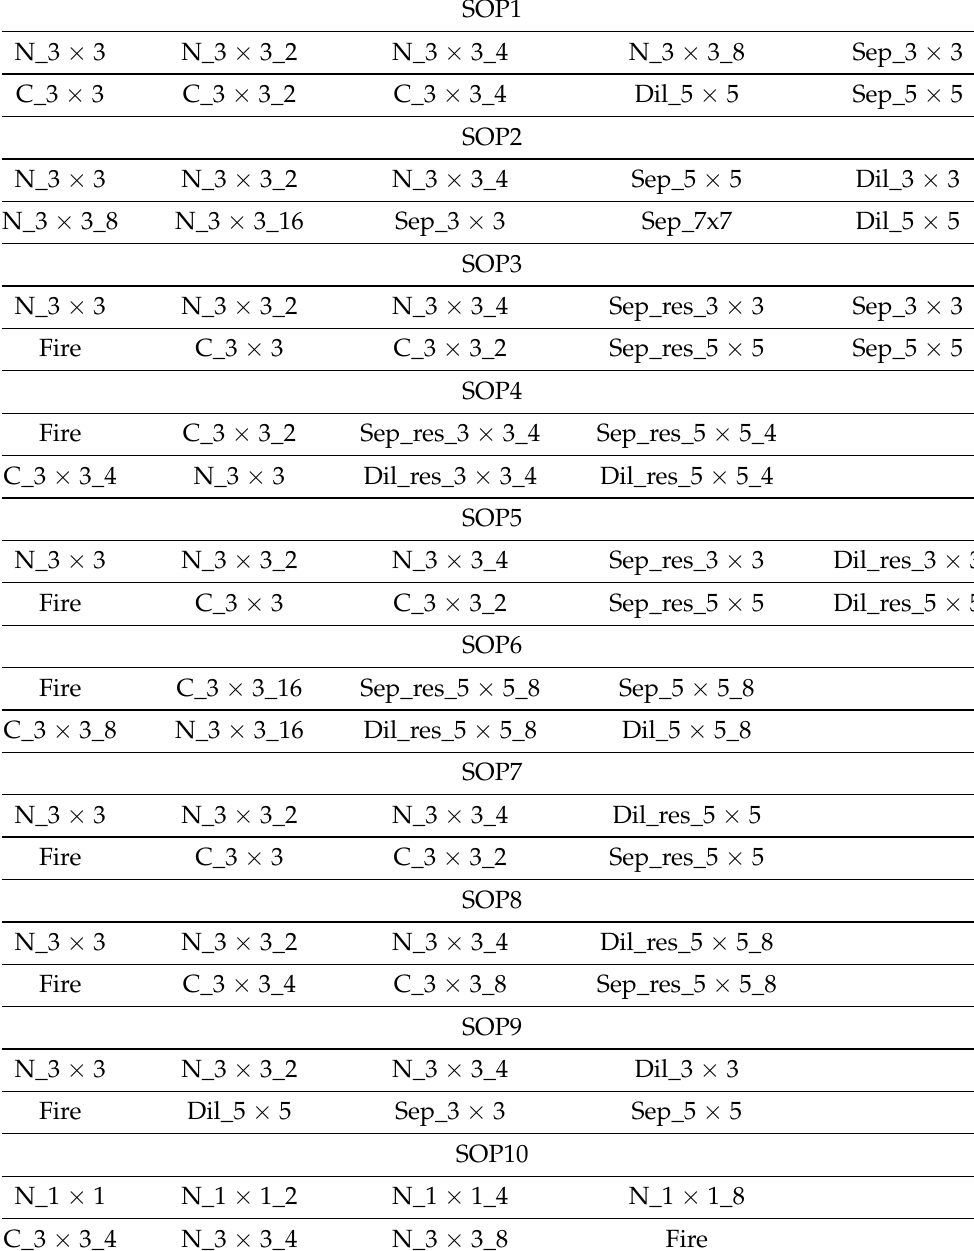
Table A2. Different sets of operators in the branches of reconstructed